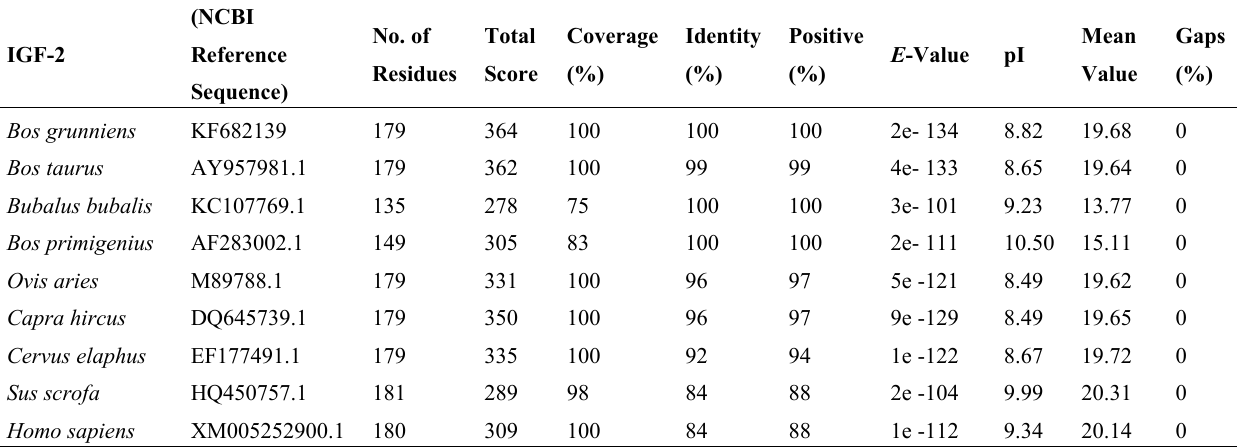
Table 2. Comparison of Tianzhu white yak ( Bos grunniens ) IGF2 and other IGF2 proteins from various, mostly similar, mammals. The comparison included number of amino acid sequence, percent identity, E -value, isoelectric point (pI) and subunit molecular weight.